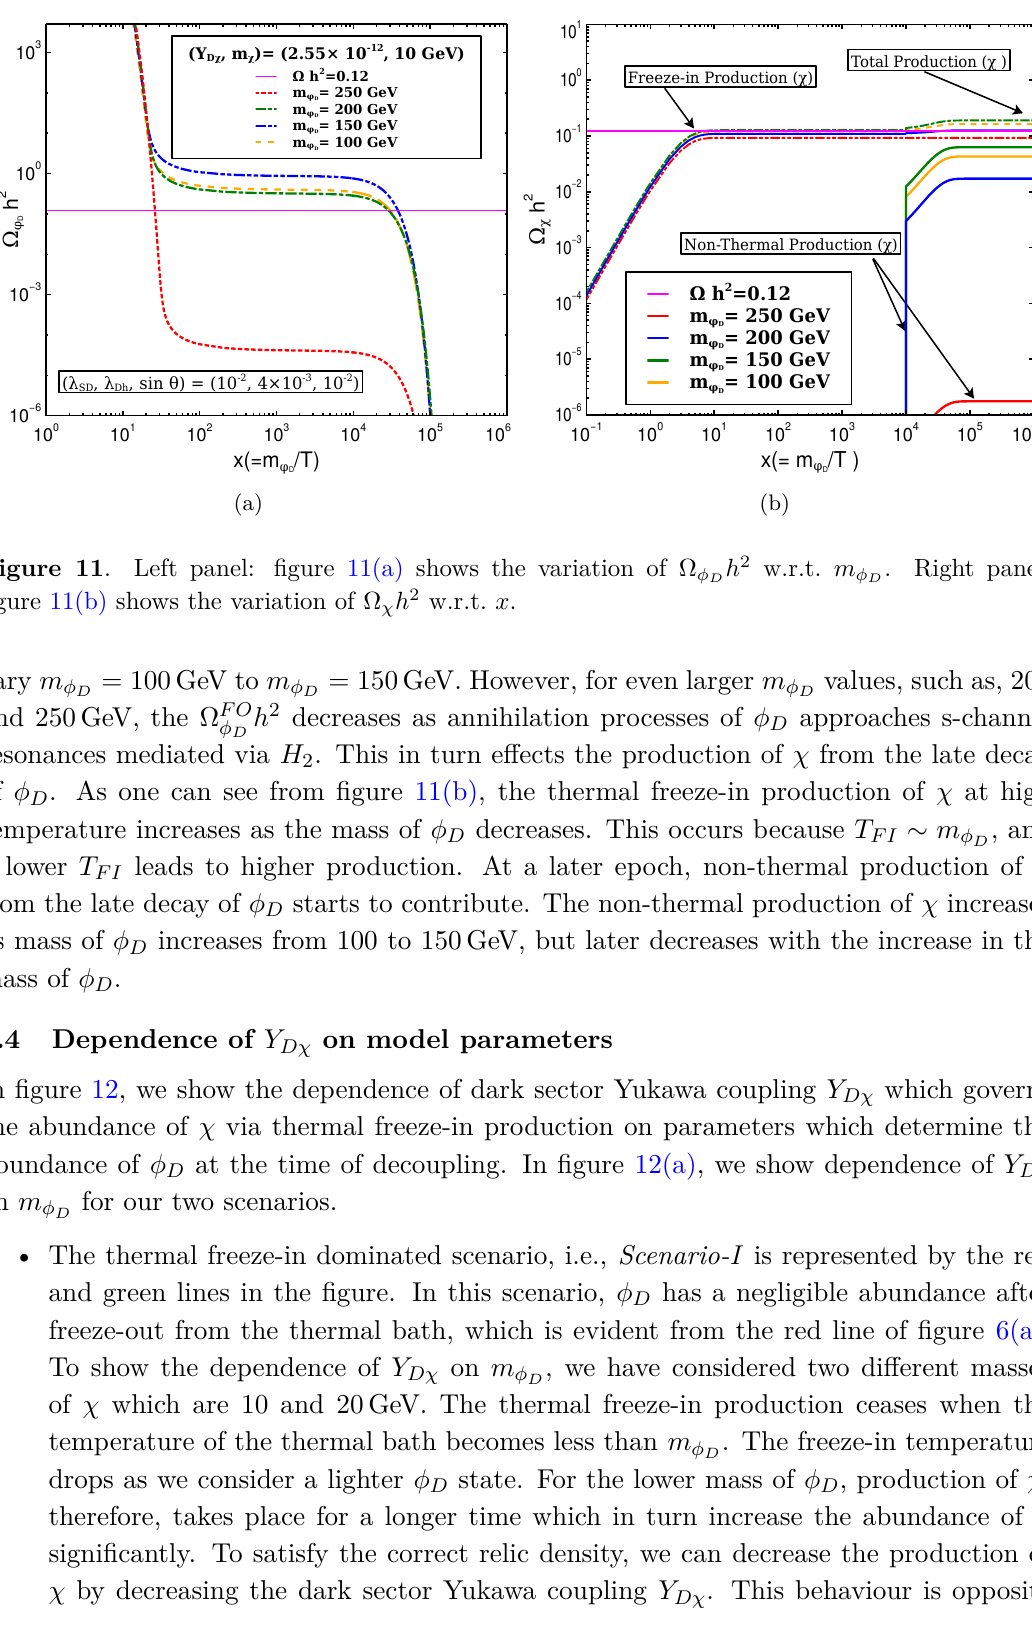
. Right panel: h 2 w.r.t. m φ D D